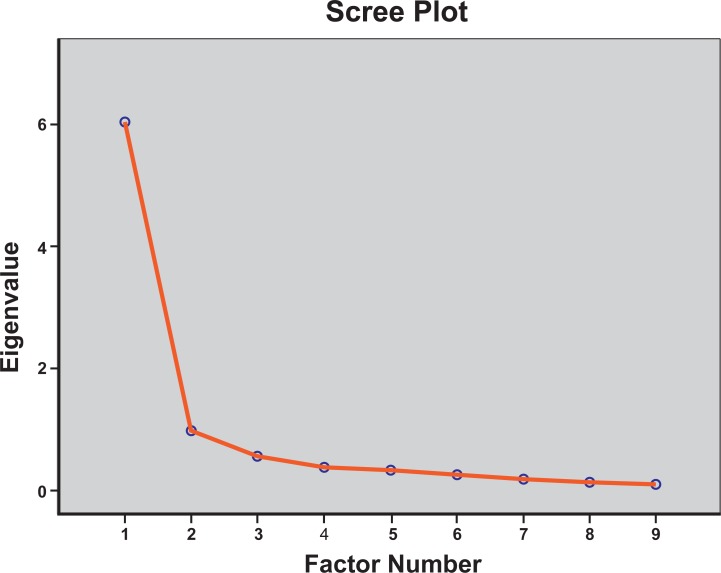
Exploratory factor analysis.Scree plot for CAIT-Arab dimensionality assessment depicting 1-factor solution.